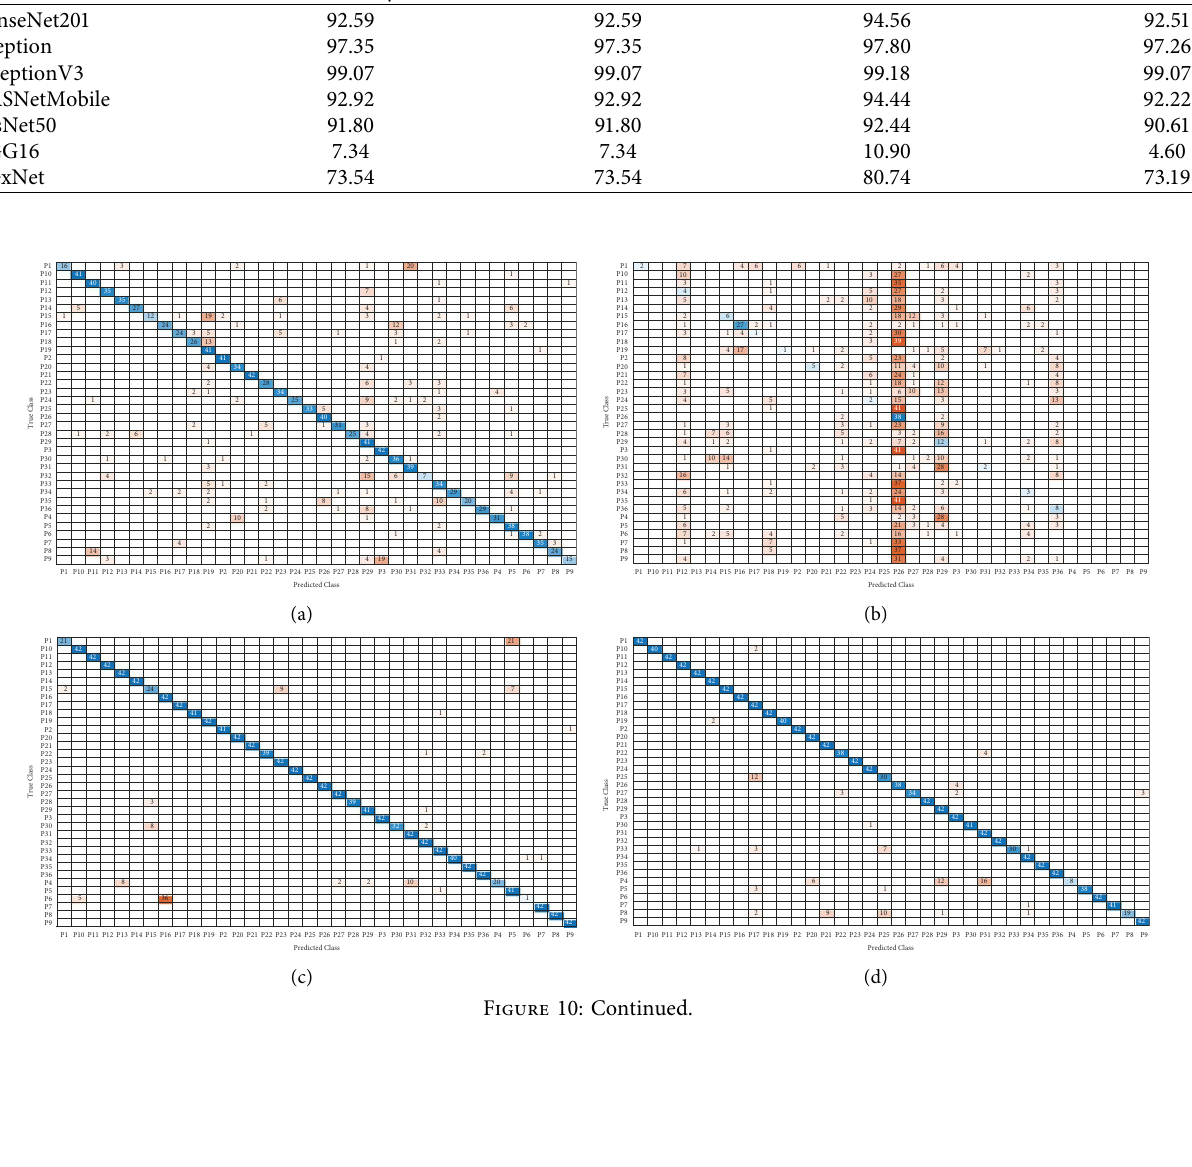
Table 2: Results for pretrained models in one holdout run. Bold means these three models have the highest accuracy.